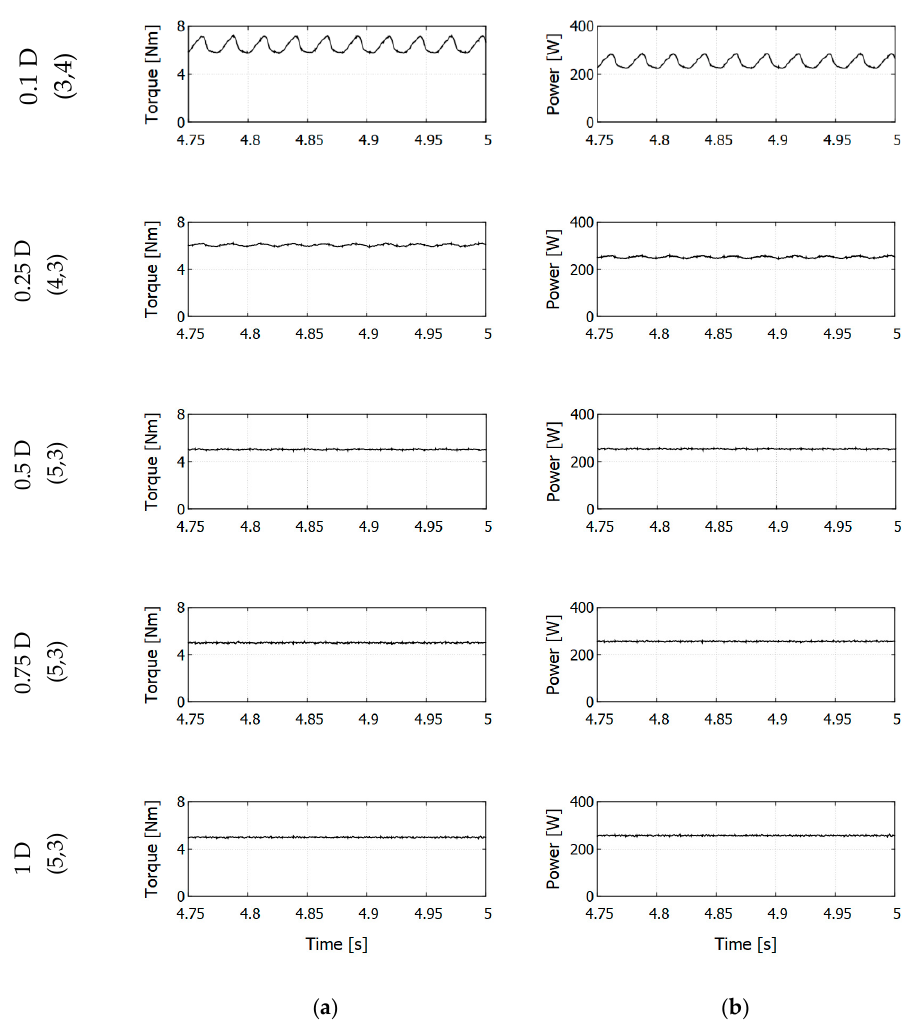
Figure 12. Plots of generated torque ( a ) and power ( b ) for di ff erent Counter-Rotating Wind Turbine (CRWT) configurations.